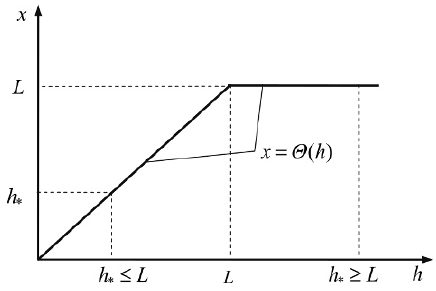
Figure 3. Penetration into a semi-infinite shield. Description of the contact area of impactor shield